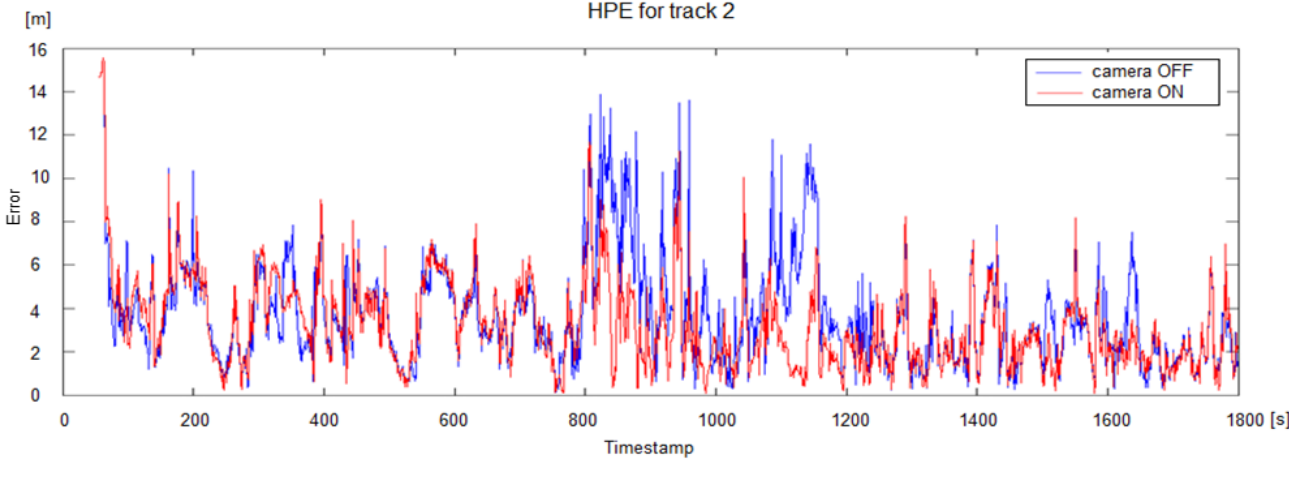
Figure 5. Experimental configuration.